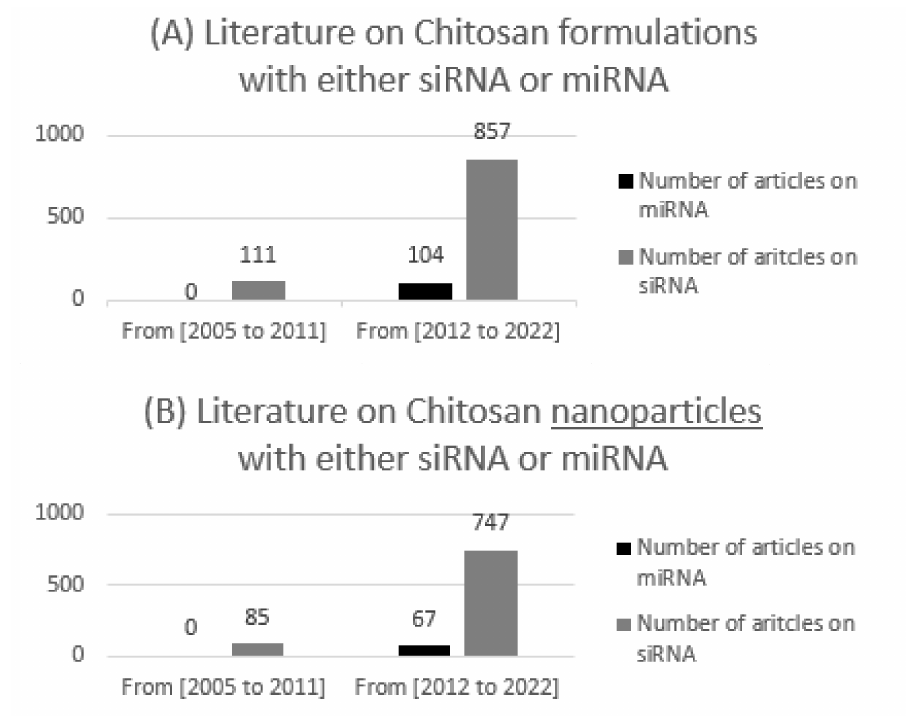
Figure 3. The number of publications on chitosan with either siRNA or miRNA between 2005 and 2011, and 2012–2022 using Web of Science library, with ( A ) demonstrating all formulations and ( B ) demonstrating nanoparticles